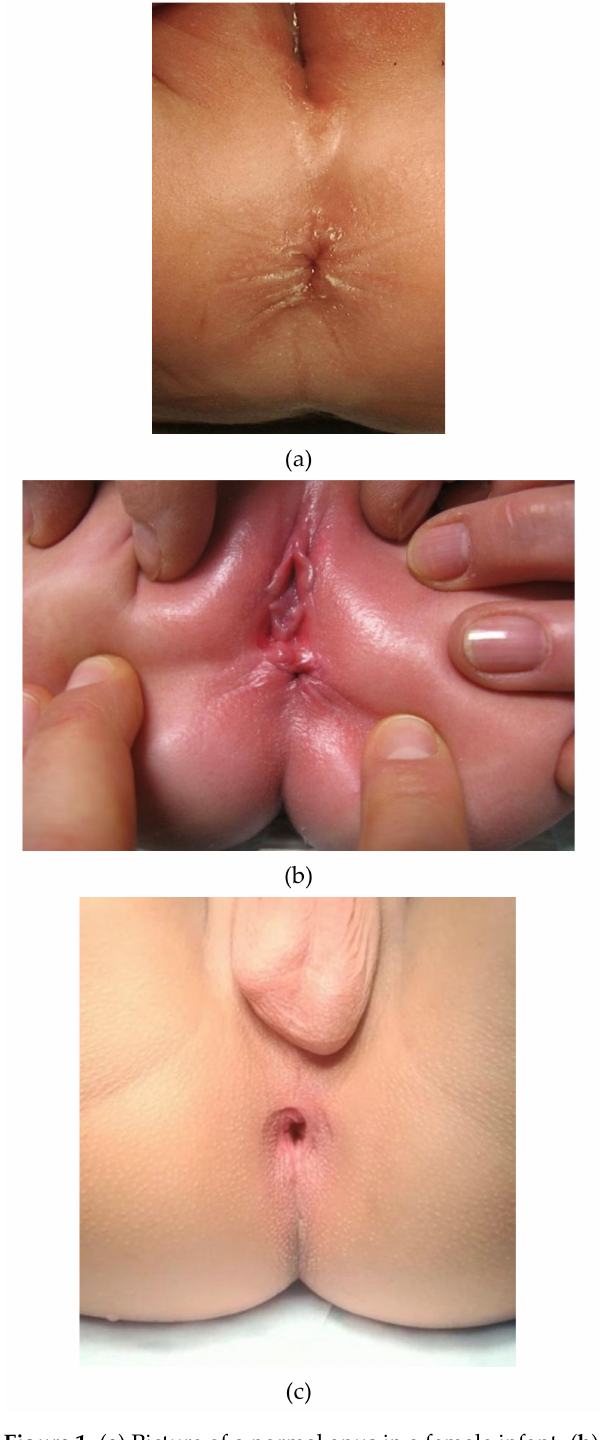
Figure 1. ( a ) Picture of a normal anus in a female infant. ( b ) Picture of an anterior anus in a female infant. Note the proximity of the anal opening to the external genitalia. ( c ). Picture of a non- stenotic perineal fistula. The sphincter muscle complex does not encircle the anal opening along the anterior